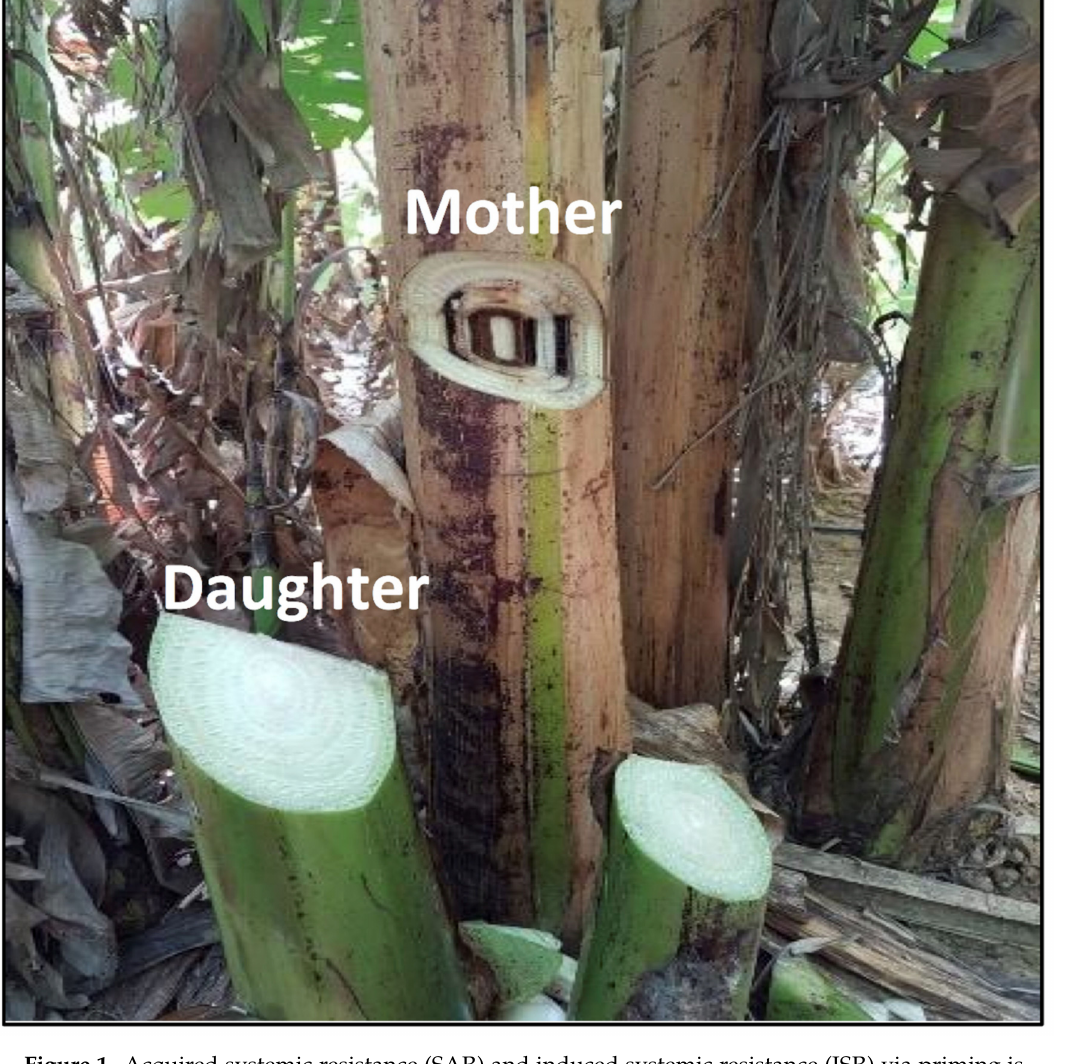
Figure 1. Acquired systemic resistance (SAR) and induced systemic resistance (ISR) via priming is activated by TTO in banana trees infected Fusarium oxysporum f. sp. cubense (Foc) race 1. Leaf sprays of TTO on infected mother banana trees induced protection against Fusarium oxysporum f. sp. cubense (Foc) race 1 in new plants (daughters)